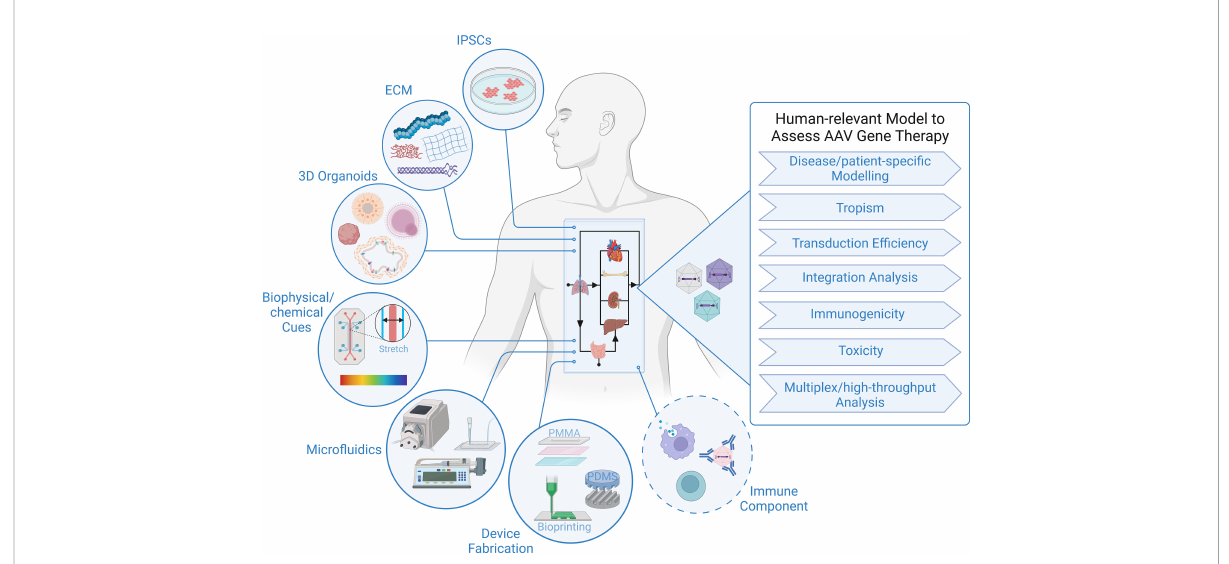
FIGURE 1 Human-relevant Preclinical Model to Accelerate AAV Gene Therapy Studies. Representation of critical components constituting body-on-a-chip platform that can be used to assess outcome of AAV gene therapy in the context of a human system. Addition of an immune component is essential to increase the predictive value of a model to study viral gene